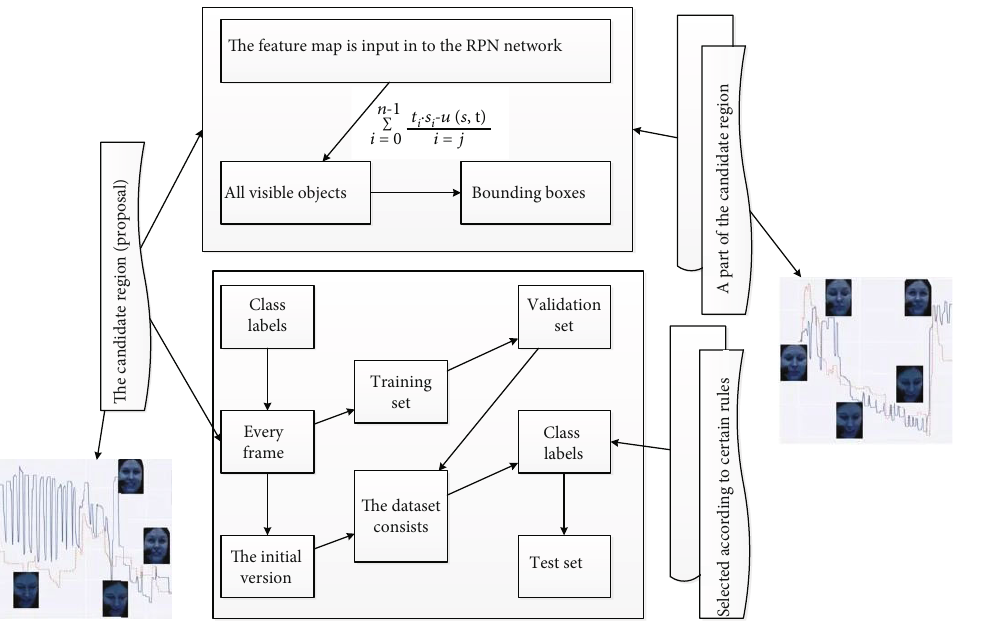
Figure 1: Topology of interactive vocal guidance Table 1: Description of frequency of psychological intervention system.